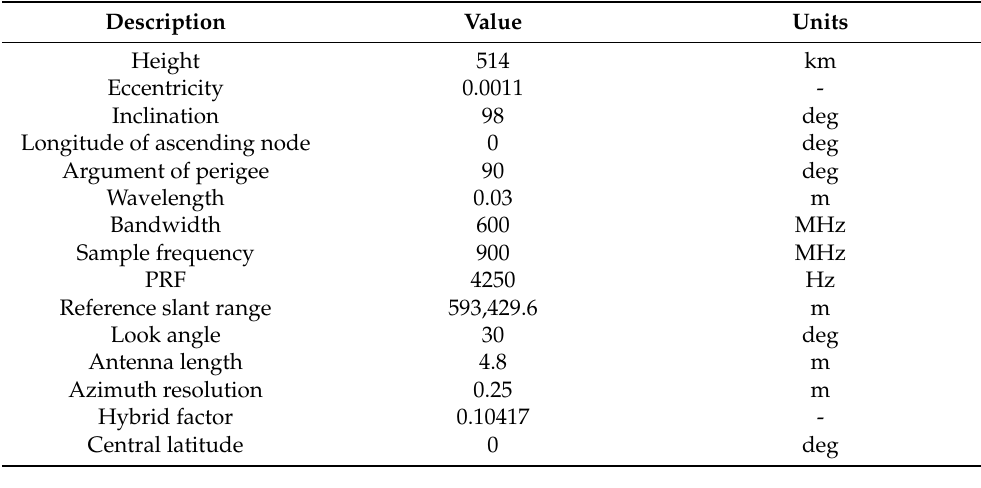
Table 3. List of simulation parameters.